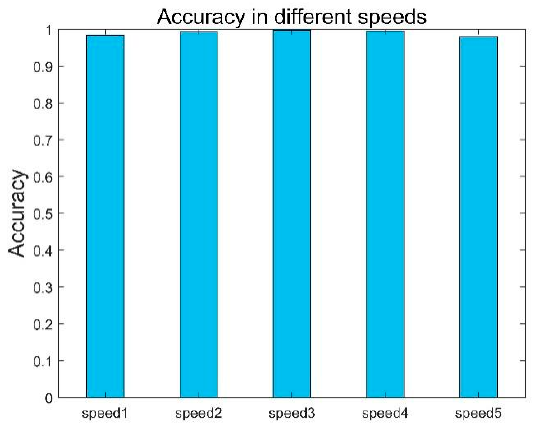
Figure 13. Performance at different speeds.